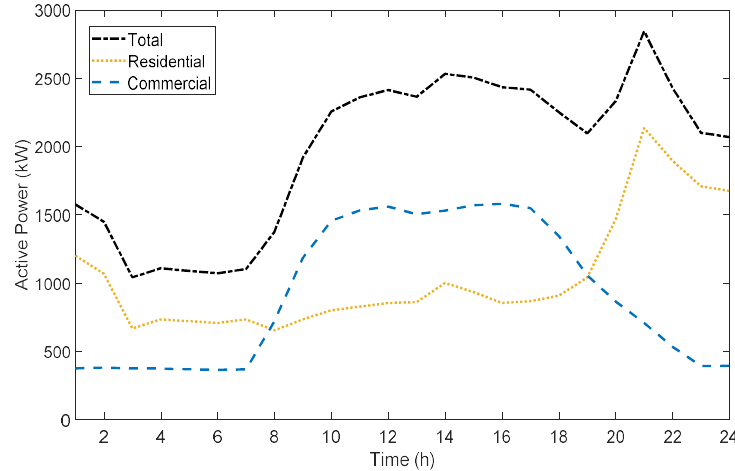
Figure 3. Aggregated residential, commercial, and total load.